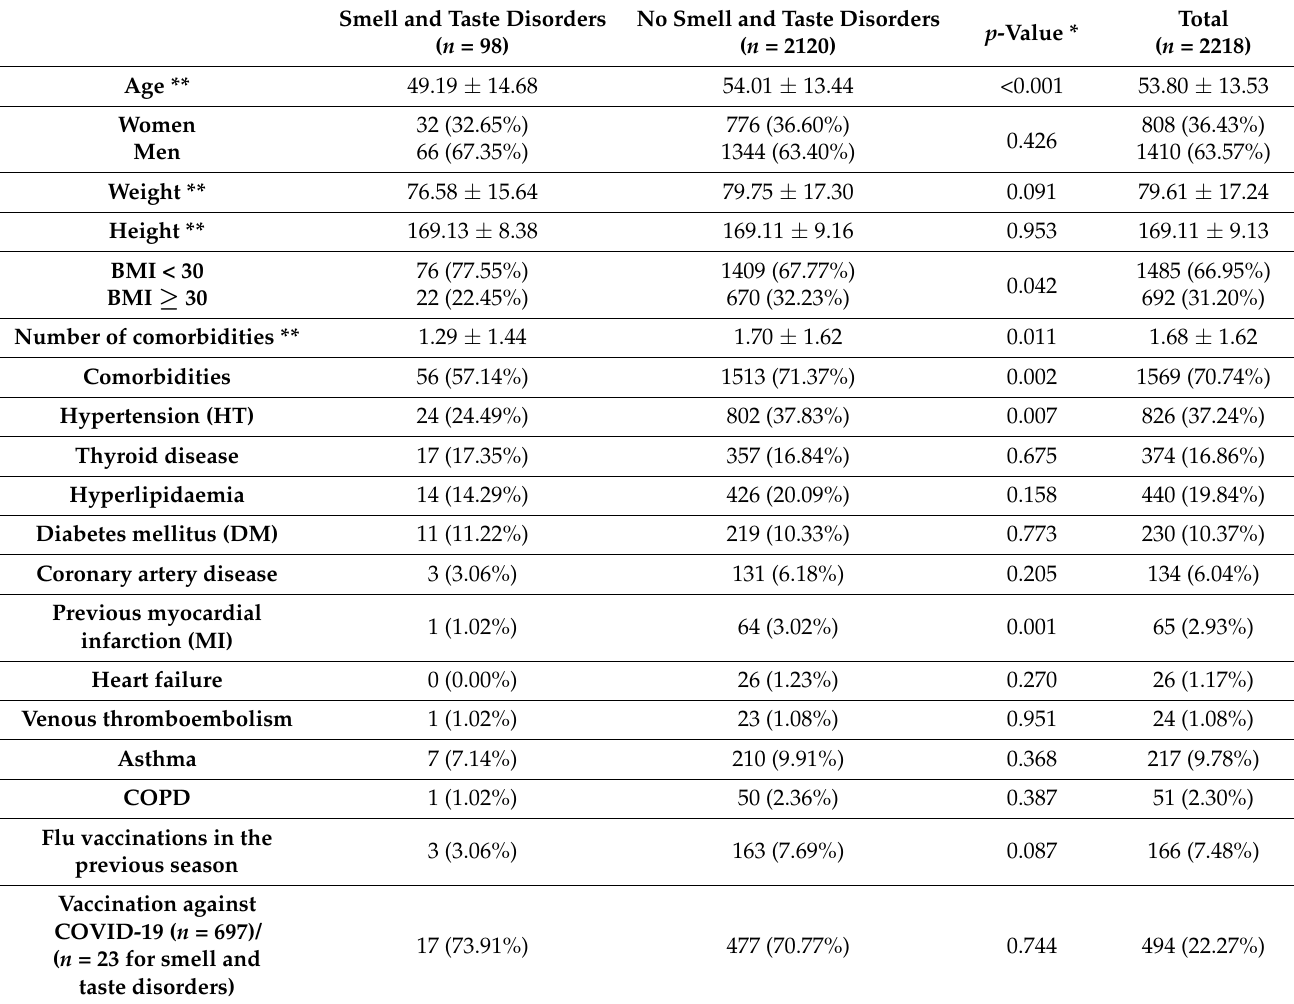
Table 1. Patient characteristics—differences between groups with and without persistent smell and taste